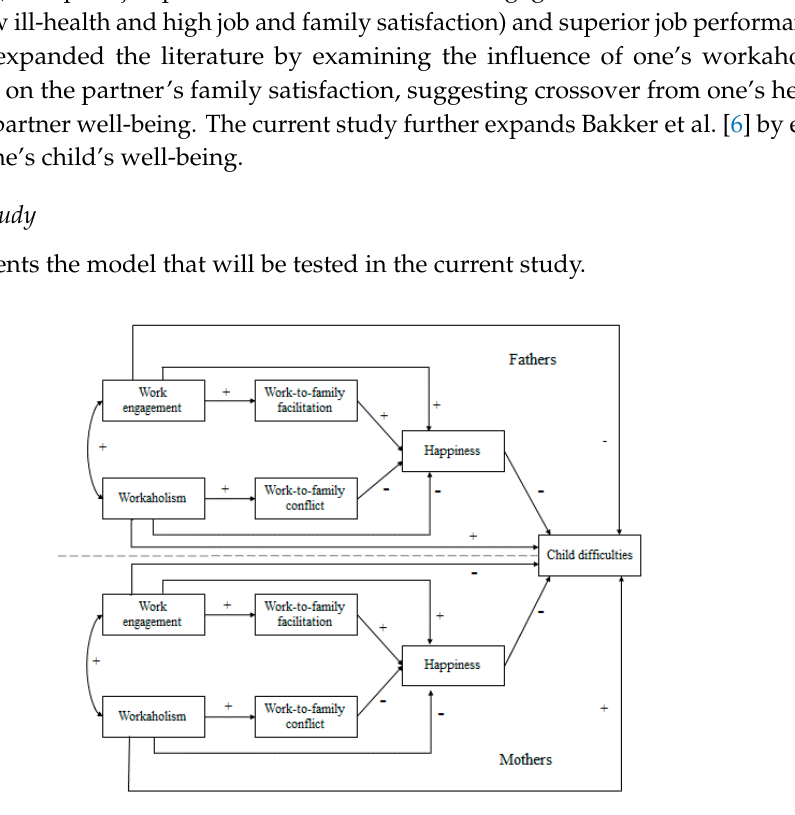
Figure 1. The hypothesized model in the present study. Note: + hypothesized relationship positive, —hypothesized relationship